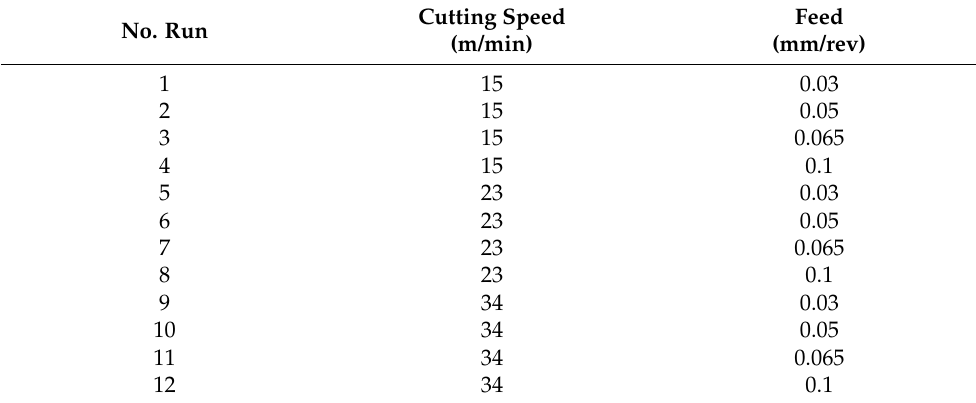
Table 3. Cutting parameter settings used during the experimental tests. Depth of cut of 0.5 mm for all the tests.